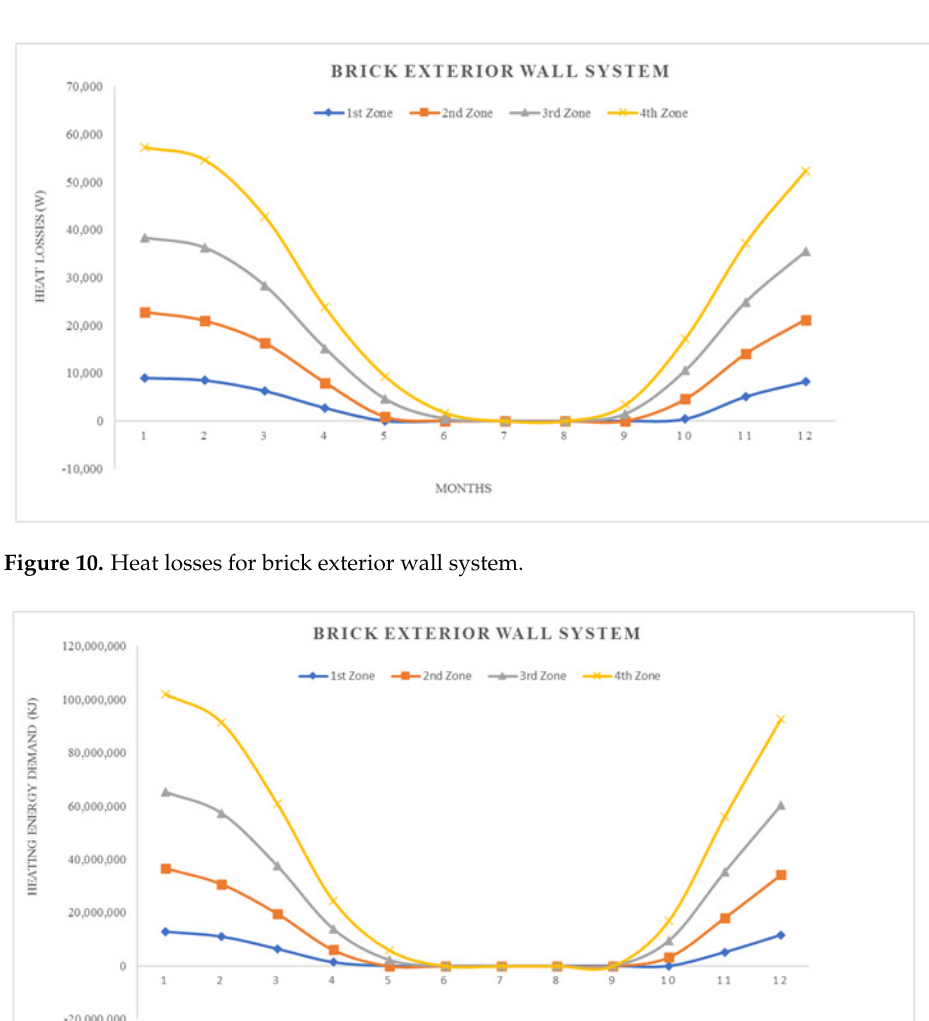
Figure 9. Heating energy demand for AAC exterior wall system .